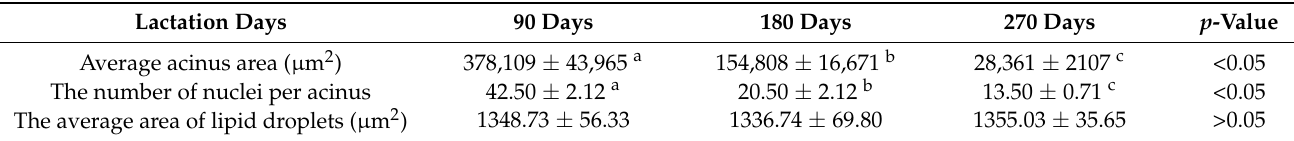
Table 2. The acinus area, lipid droplets area, and number of nuclei in an acinus.